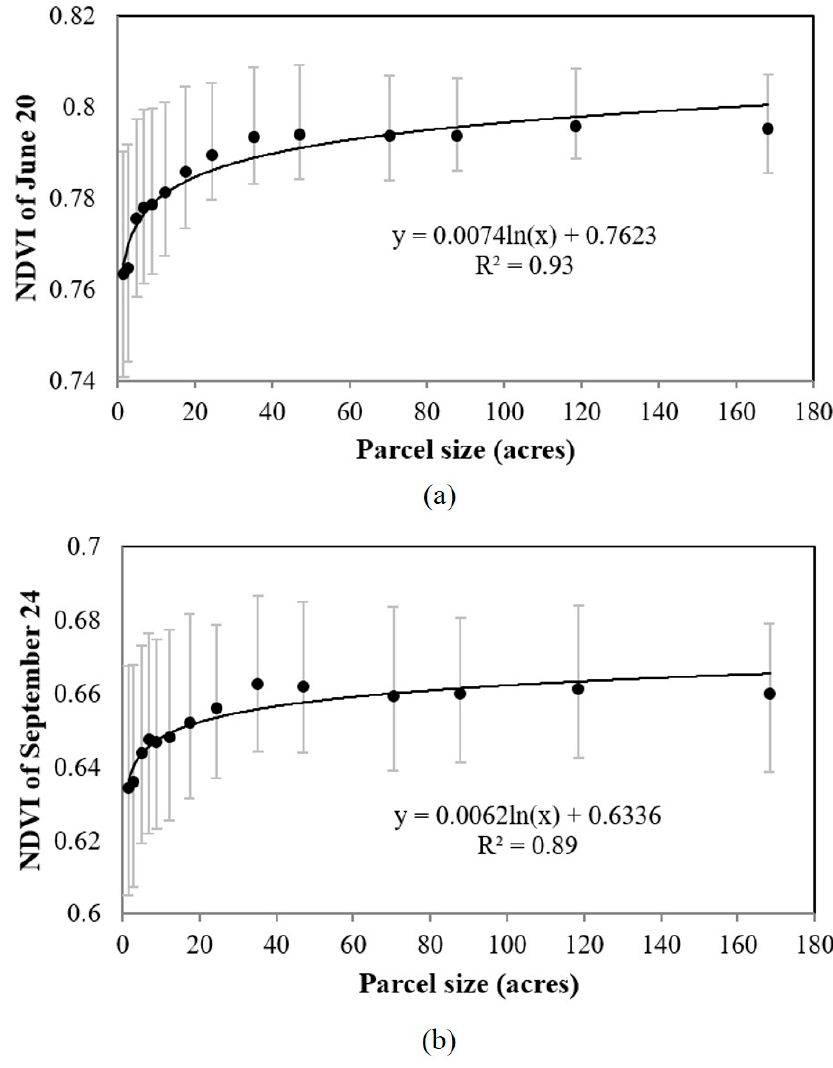
Figure 11. NDVI values in peak season versus parcel size ( a ) and NDVI values in descending season versus parcel size; ( b ). The black point is mean value of each bin, the error bar is the 0.25–0.75 percentiles, and the solid line is the regression line.